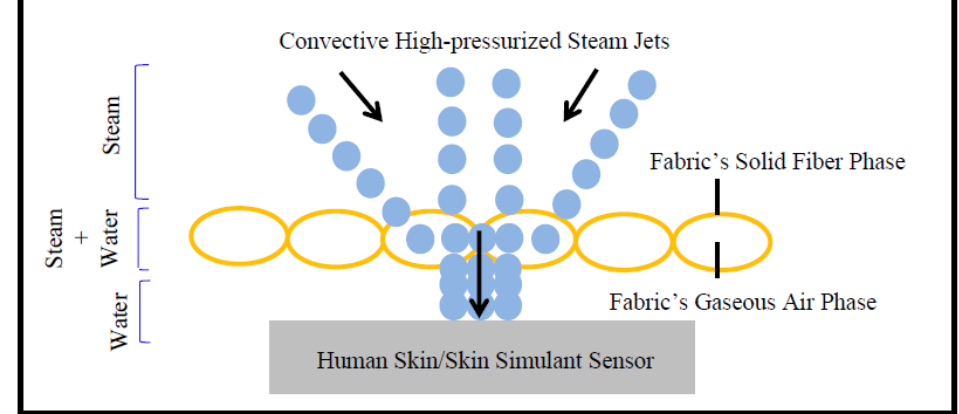
Figure 10. Steam transfer mechanisms through regular fabrics.